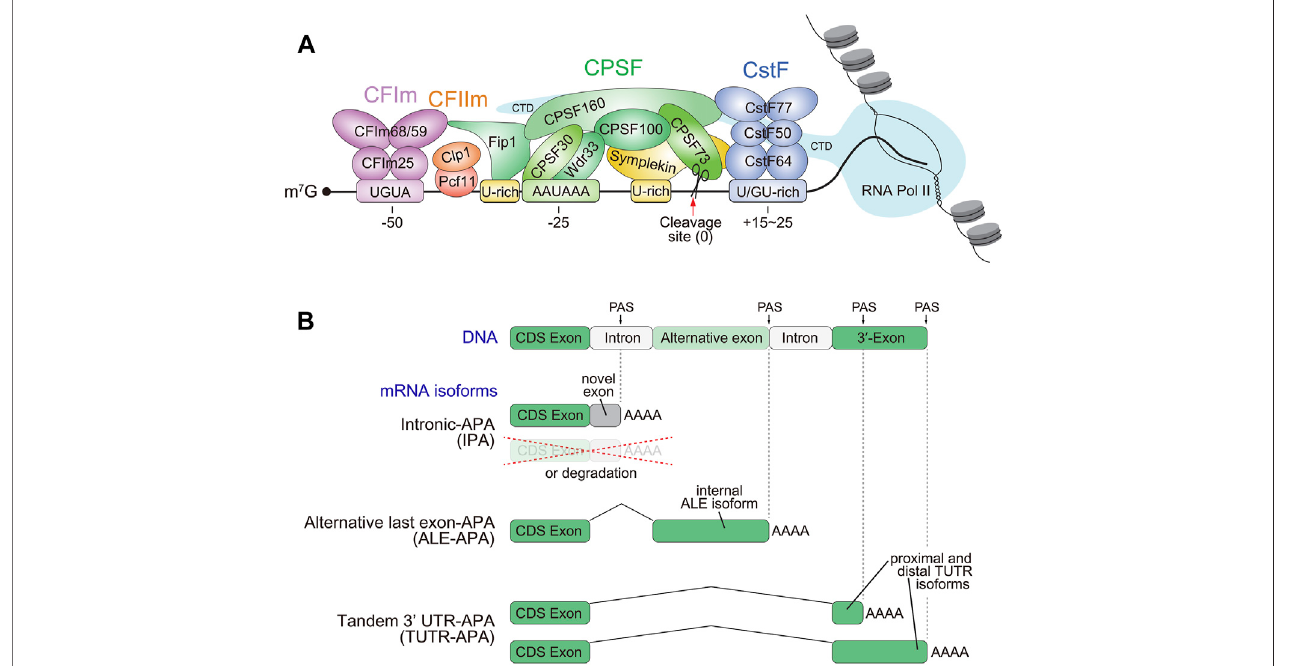
FIGURE 1 | The core cleavage and polyadenylation (CPA) machinery and varieties of alternative polyadenylation (APA) isoforms. (A) The CPA machinery, and speci fi callytheCPSF73endonucleasesubunitoftheCPSFcomplex,cleavesthe3 ’ endsofpre-mRNAtranscripts,creatingasiteforuntemplatedpolyadenylationthatis typical of mature mRNAs. This reaction is guided by the polyadenylation signal (PAS), namely AAUAAA and related sequences. Since the PAS contains limited information, speci fi city can be enhanced by other local sequence motifs, which are recognized by other CPA complexes as depicted (CFIm, CFIIm and CstF). (B) Mostpre-mRNAtranscriptscontainmultiplefunctionalPAS,whosealternativeusagetoyielddistinct3 ’ isoformsisreferredtoasAPA.Amajorityofmetazoantranscripts generate more than one 3 ’ UTR isoform, referred to as tandem 3 ’ UTR (TUTR) isoforms. These encode the same protein but have different 3 ’ UTR extents. Functional PAS can also be located upstream of the terminal exon in the genome. When their usage yields stable alternative transcripts, these generate alternative last exon (ALE) variants that encode different coding capacity and non-overlapping 3 ’ UTRs. Other varieties of upstream APA, including within annotated intronic regions, can generate truncated proteins or cause the isoforms to be degraded. These are often referred to as intronic polyadenylation (IPA), although their functional utilization necessarily creates new 3 ’